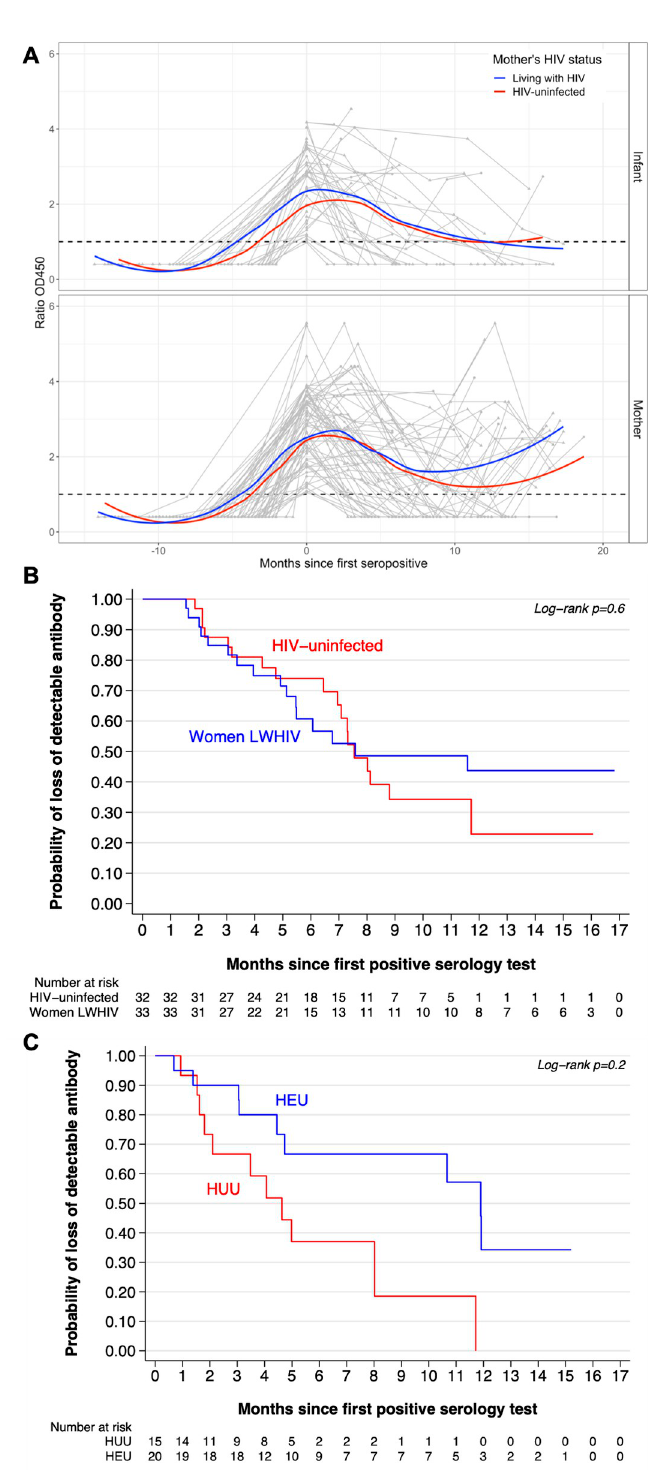
Fig 2. Detection of SARS-CoV-2 antibody among mothers and infants over time. (A) SARS-CoV-2 antibody levels over time relative to the first seropositive time point (0 months). Individual patterns in infants (top) and mothers (bottom) are shown in grey. Grouped by maternal HIV status, running means are shown for HIV-uninfected women or HIV-unexposed infants in black and women living with HIV or HIV-exposed infants in red. Limit of detection denoted by dashed vertical line. (B) and (C) are Kaplan-Meier hazard functions for participants’ estimated time to loss